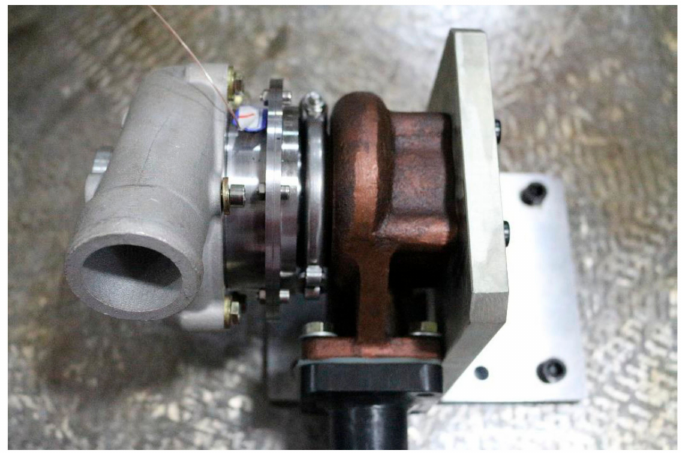
Figure 7. Oil-free turbocharger host machine by Hunan University